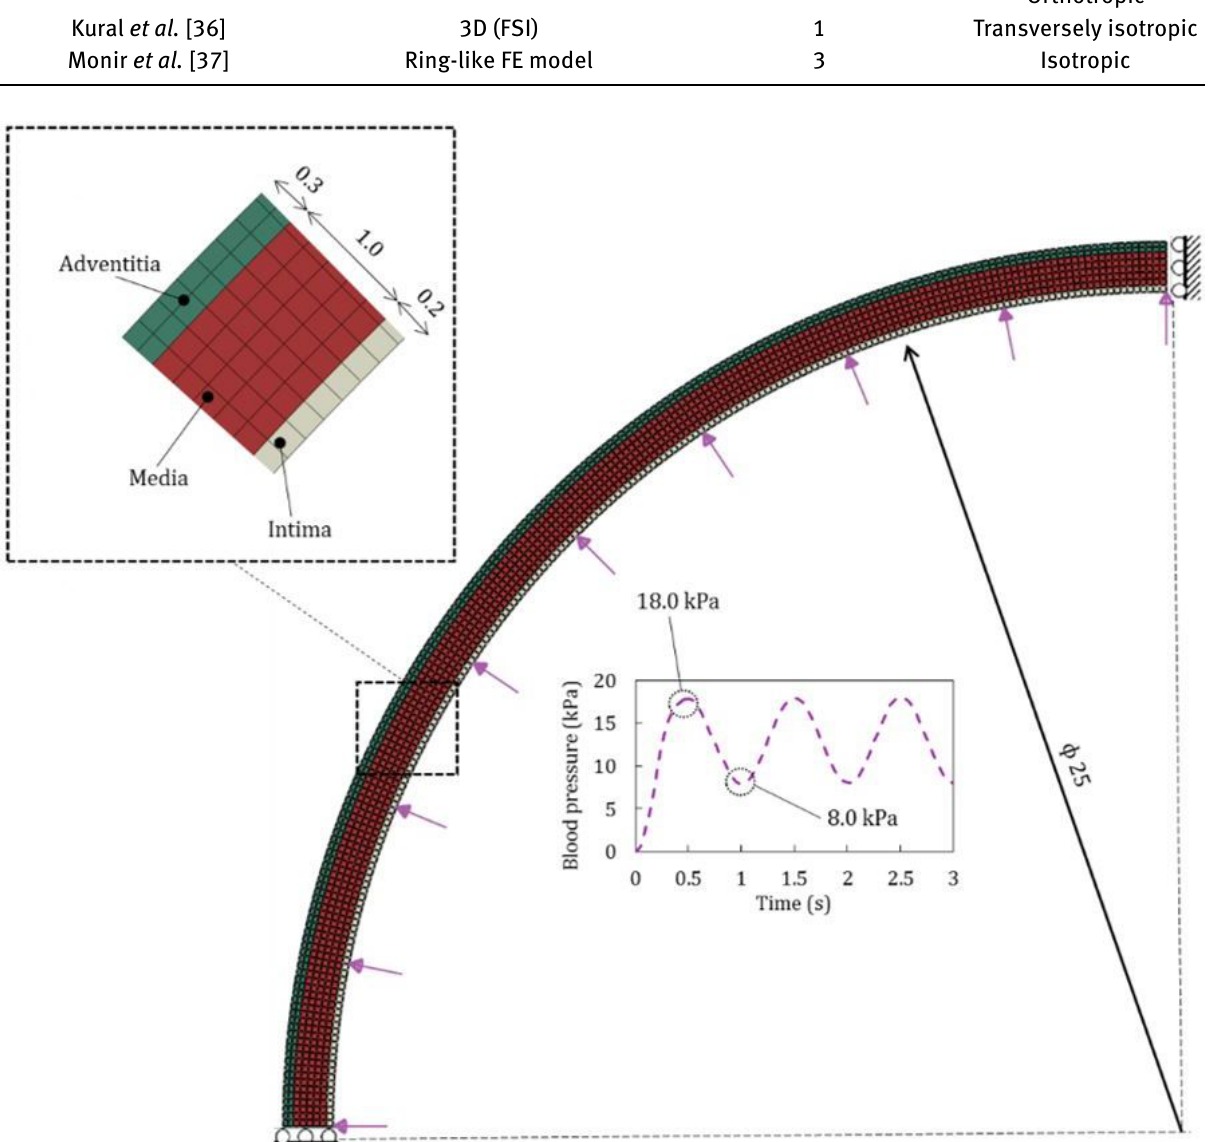
Figure 3: Finite element model of the human aorta, dimensions (unit: mm) and loading